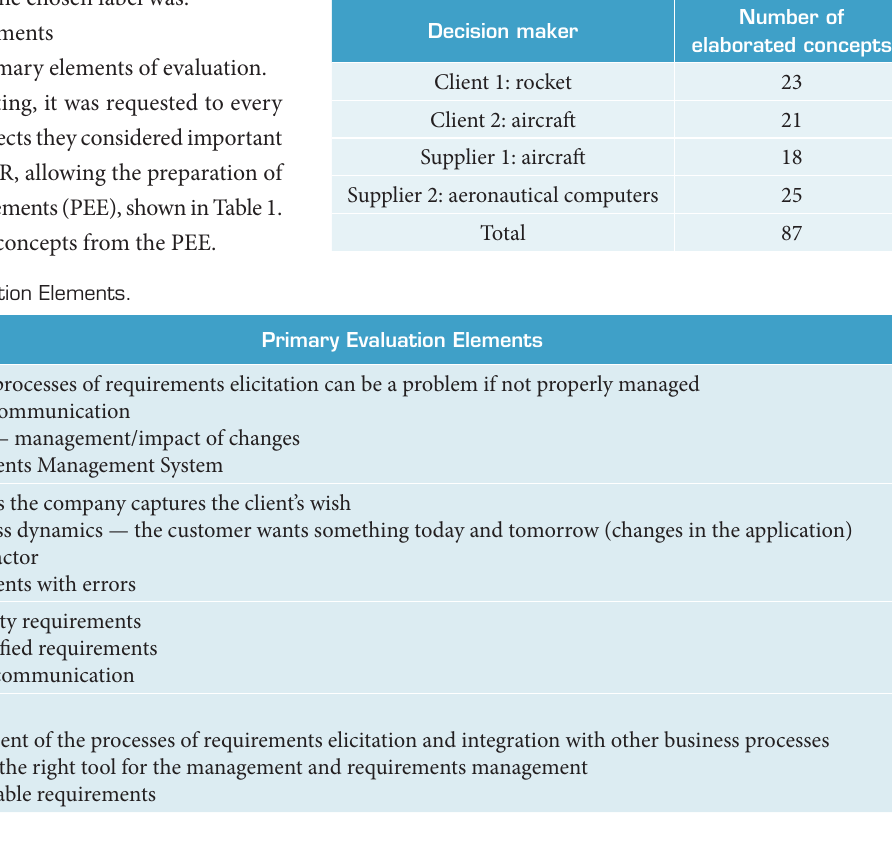
table 2. Concepts drawn from the initial